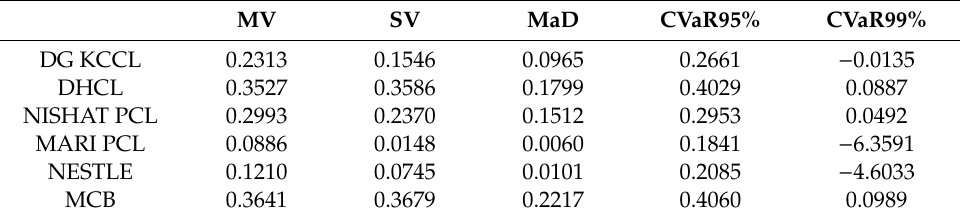
Table 1. Optimal portfolio compositions for economic crisis period